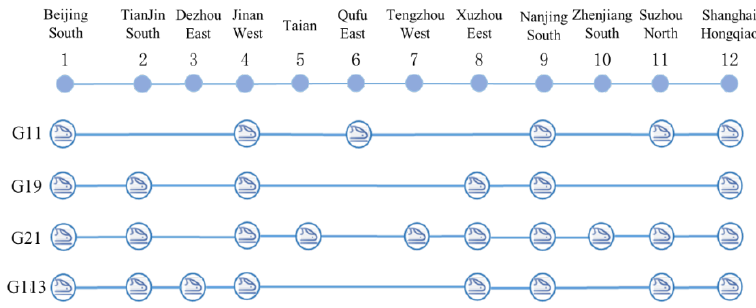
Figure 4. The current train stop plan.